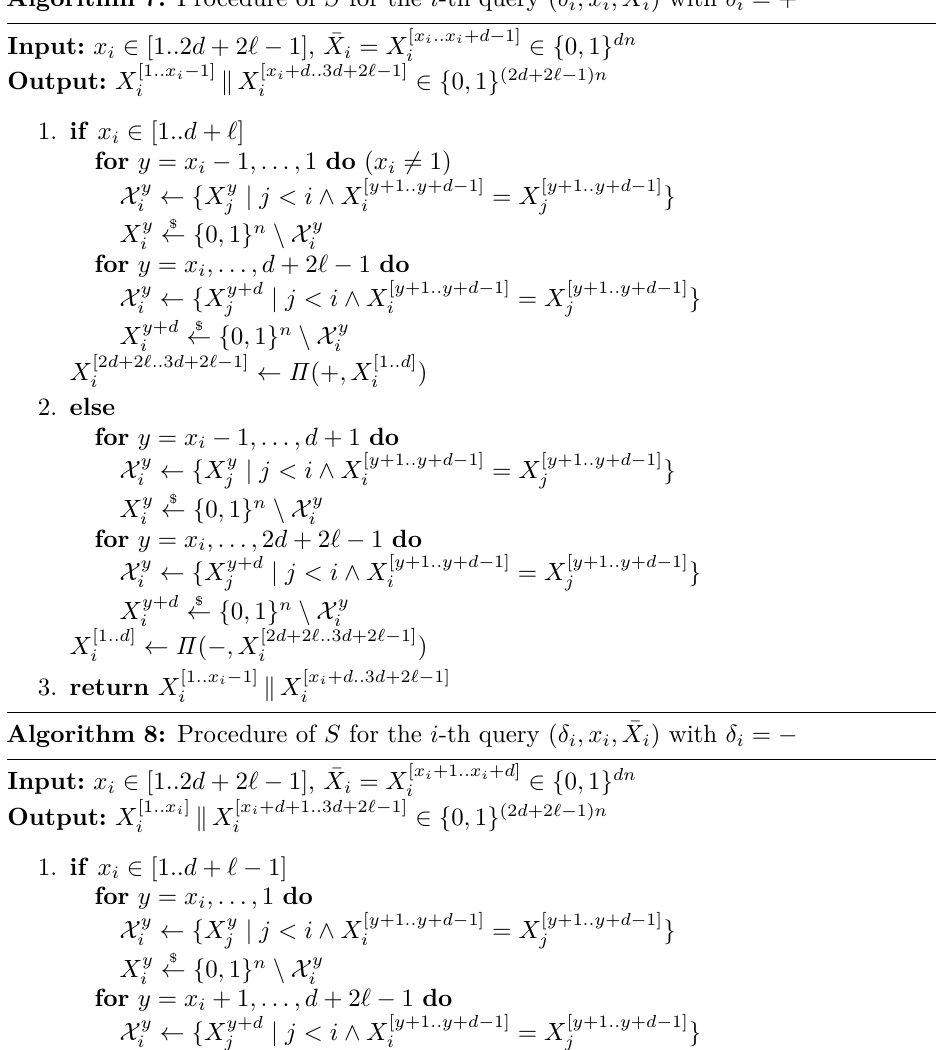
Algorithm 7: Procedure of S for the i -th query ( δ